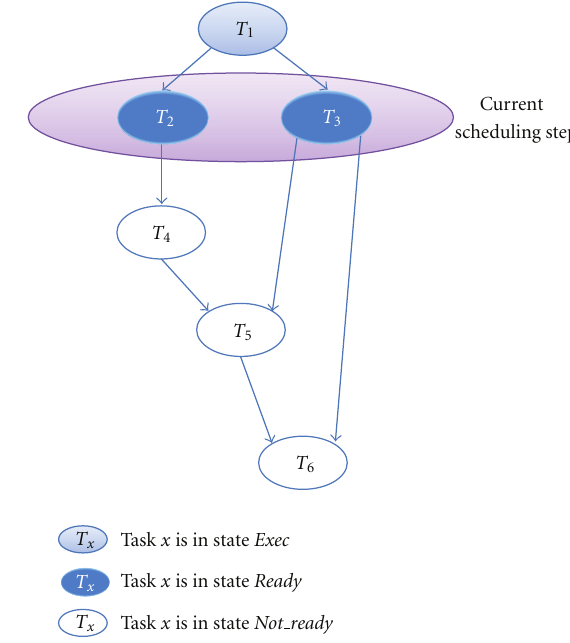
Figure 6: Task graph to illustrate the functionality of the schedul-